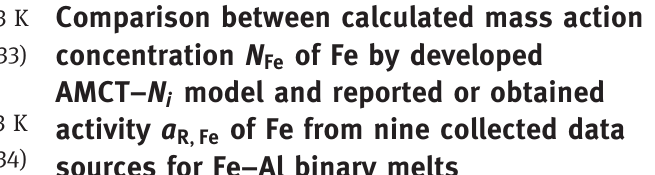
Figure 9: Relationship between mole fraction x Al of Al and calculated activity coefficient ln γ (b) by developed AMCT – N i model for Fe – Al binary melts at four temperatures of 1823, 1873, 1923, and 1973 K (1550, 1600, 1650, and 1700°C), respectively.